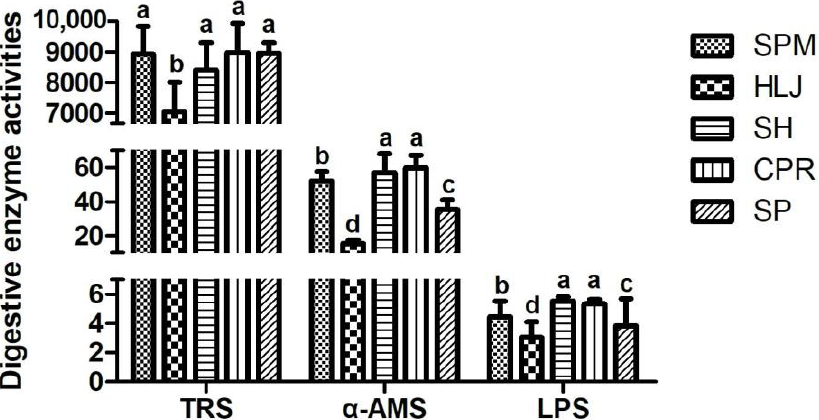
Figure 3. Digestive enzyme activities in five species of common carp. Digestive enzymes were